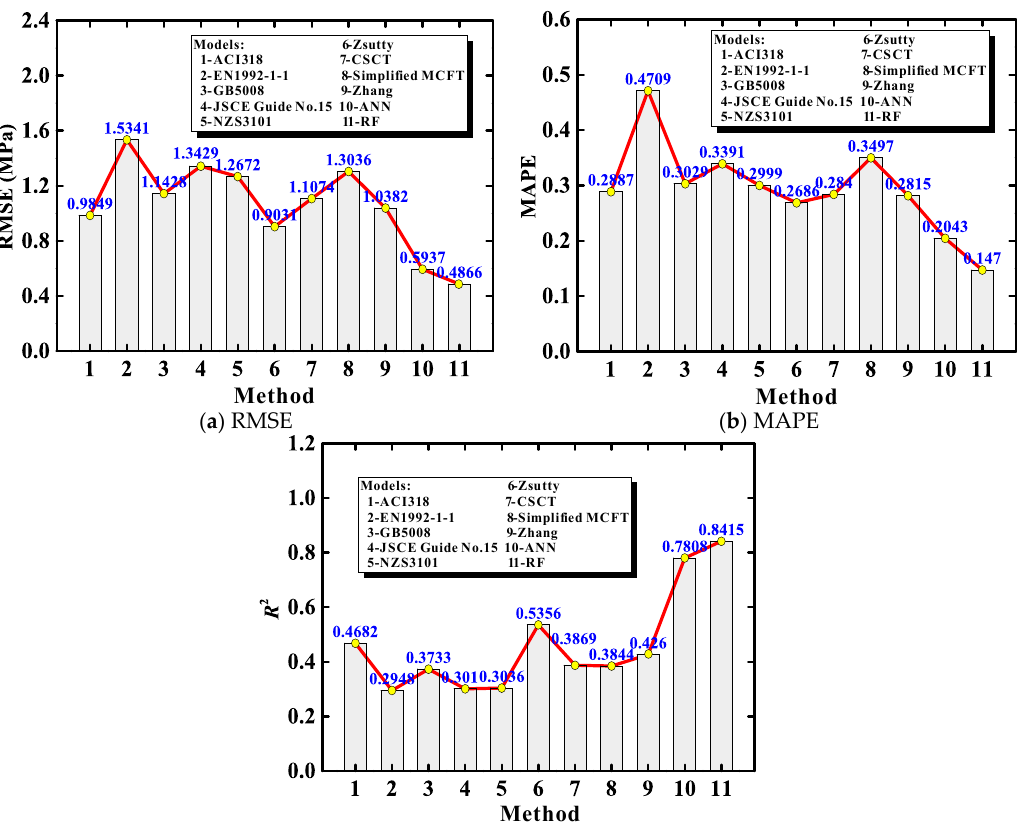
Figure 6. Predictive performance evaluation for different models.